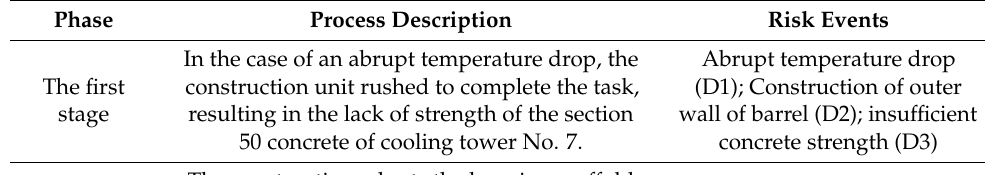
Table 2. Analysis of phased risk events in